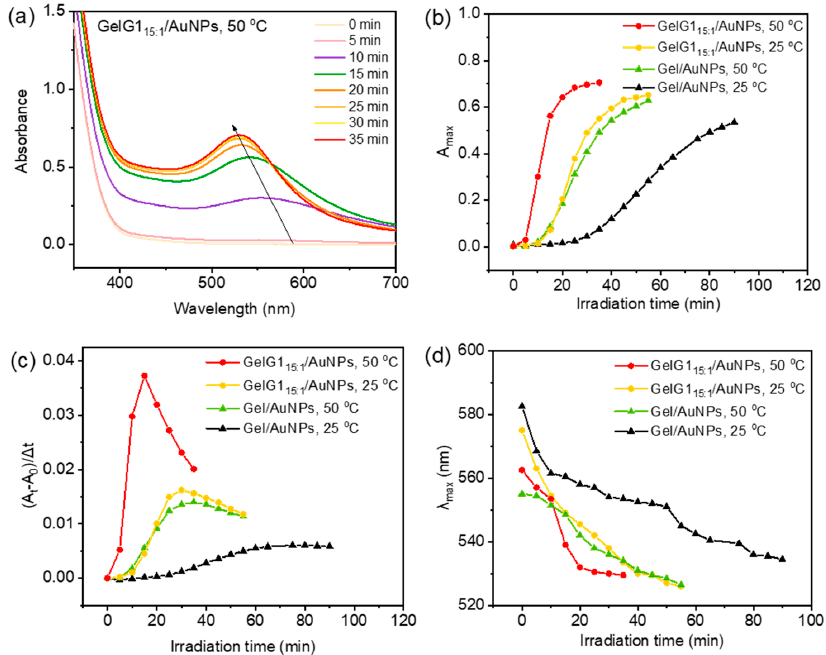
Figure 5. ( a ) UV / vis absorption spectra of AuNPs obtained by in situ reduction of HAuCl 4 (0.1 mg/mL) with GelG1 15:1 (2 mg/mL) at 50 °C, and plots of A max ( b ), reduction rate ( c ) and λ max ( d ) with irradiation time for in situ reduction of HAuCl 4 (0.1 mg/mL) with GelG1 15:1 , GelG1 5:1 and gelatin (2 mg/mL) at 50 °C. The data from reduction at 25 °C were also included for comparison.